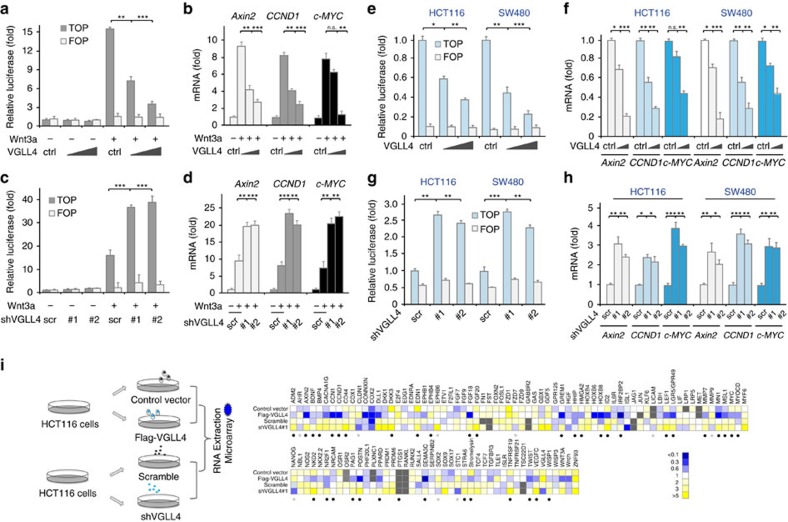
VGLL4 inhibits Wnt/β-catenin signalling.(a) VGLL4 inhibited in a dose-dependent manner TOP-FLASH activity in HEK293T cells treated with Wnt3a. (b) VGLL4 inhibited transcription of Wnt target genes in HEK293T cells treated with Wnt3a. (c,d) Knockdown of VGLL4 promotes TOP-FLASH activity (c) and transcription of Wnt target genes (d) in HEK293T cells. (e) VGLL4 inhibits TOP-FLASH activity in HCT116 and SW480 cells. (f) VGLL4 inhibits transcription of Wnt target genes in HCT116 and SW480 cells. (g,h) Knockdown of VGLL4 promotes TOP-FLASH activity (g) and transcription of Wnt target genes (h) in HCT116 and SW480 cells. (i) Microarray analysis of Wnt target genes' transcription in HCT116 cells after transfection with VGLL4 or shVGLL4. Genes negatively regulated by VGLL4 are marked by black dots; while gene positively regulated by VGLL4 are marked by grey dots. Note: Data in a–h represent the mean±S.D. from one experiment. Experiments we repeated three times. Unpaired t tests were used to compare the differece between groups. *P<0.05, **P<0.01, ***P<0.001, significant relative to control. n.s., no statistics significance; ctrl, control vector (same below); scr, scramble shRNA (same below) (Supplementary Figs 3–5).